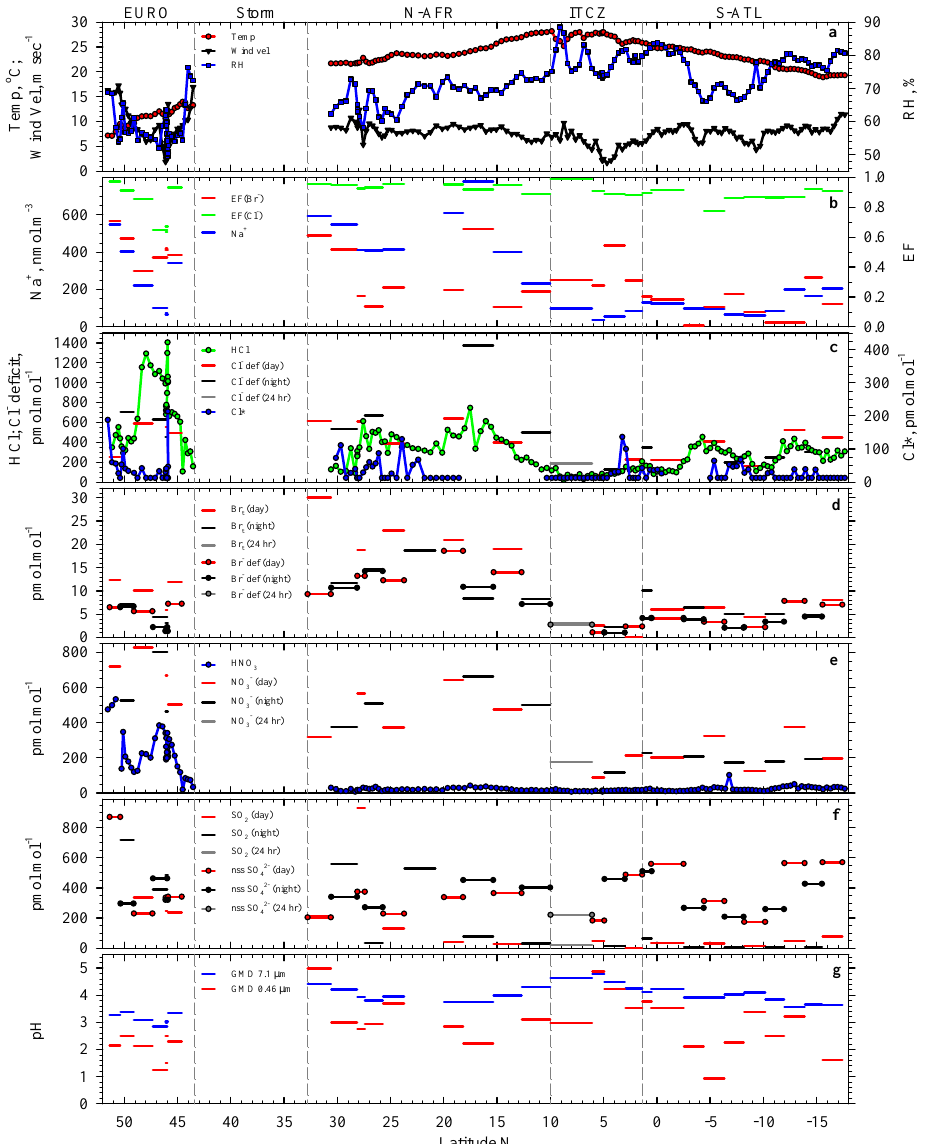
Fig. 2. Latitudinal variability in measured and directly calculated characteristics of near-surface air including (a) temperature, RH, and wind velocity averaged over each mist-chamber sampling interval; (b) particulate Na + , EF(Cl − ), and EF(Br − ); (c) HCl, Cl*, and particulate Cl − deficit; (d) Br t and particulate Br − deficit; (e) HNO 3 and particulate NO − ; (f) SO 2 and particulate nss SO 2 − ; and (g) pH of GMD 7.1- µ m 3 4 and GMD 0.46- µ m aerosol size fractions inferred from the measured HCl phase partitioning. In panel f, SO 2 during the first sampling interval (2277pmolmol − 1 ) is off scale. Values below DLs are plotted as 0.5*DLs. Vertical dashed lines partition major transport